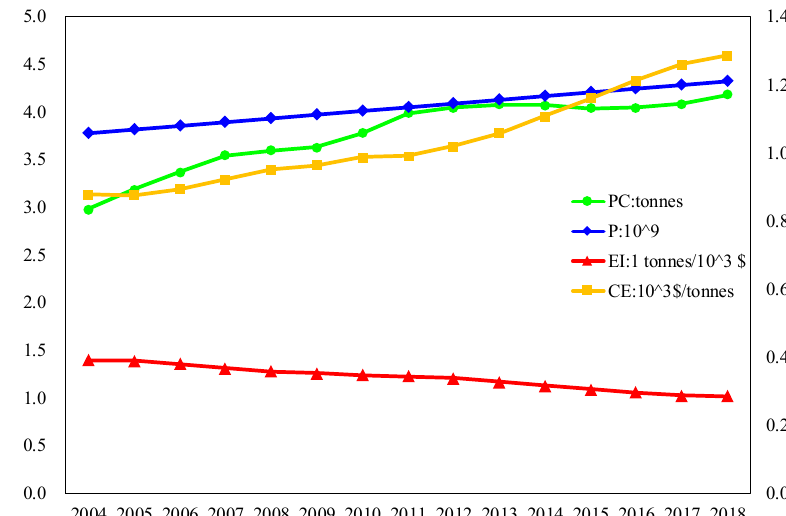
Figure 3. Changes in factors during 2004–2018.